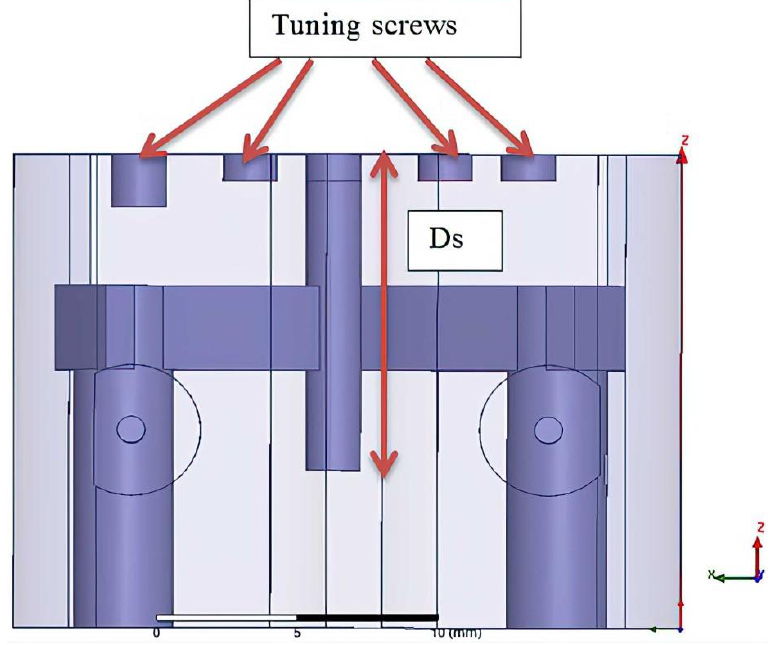
Figure 8. Penetration depth of coupling screw.